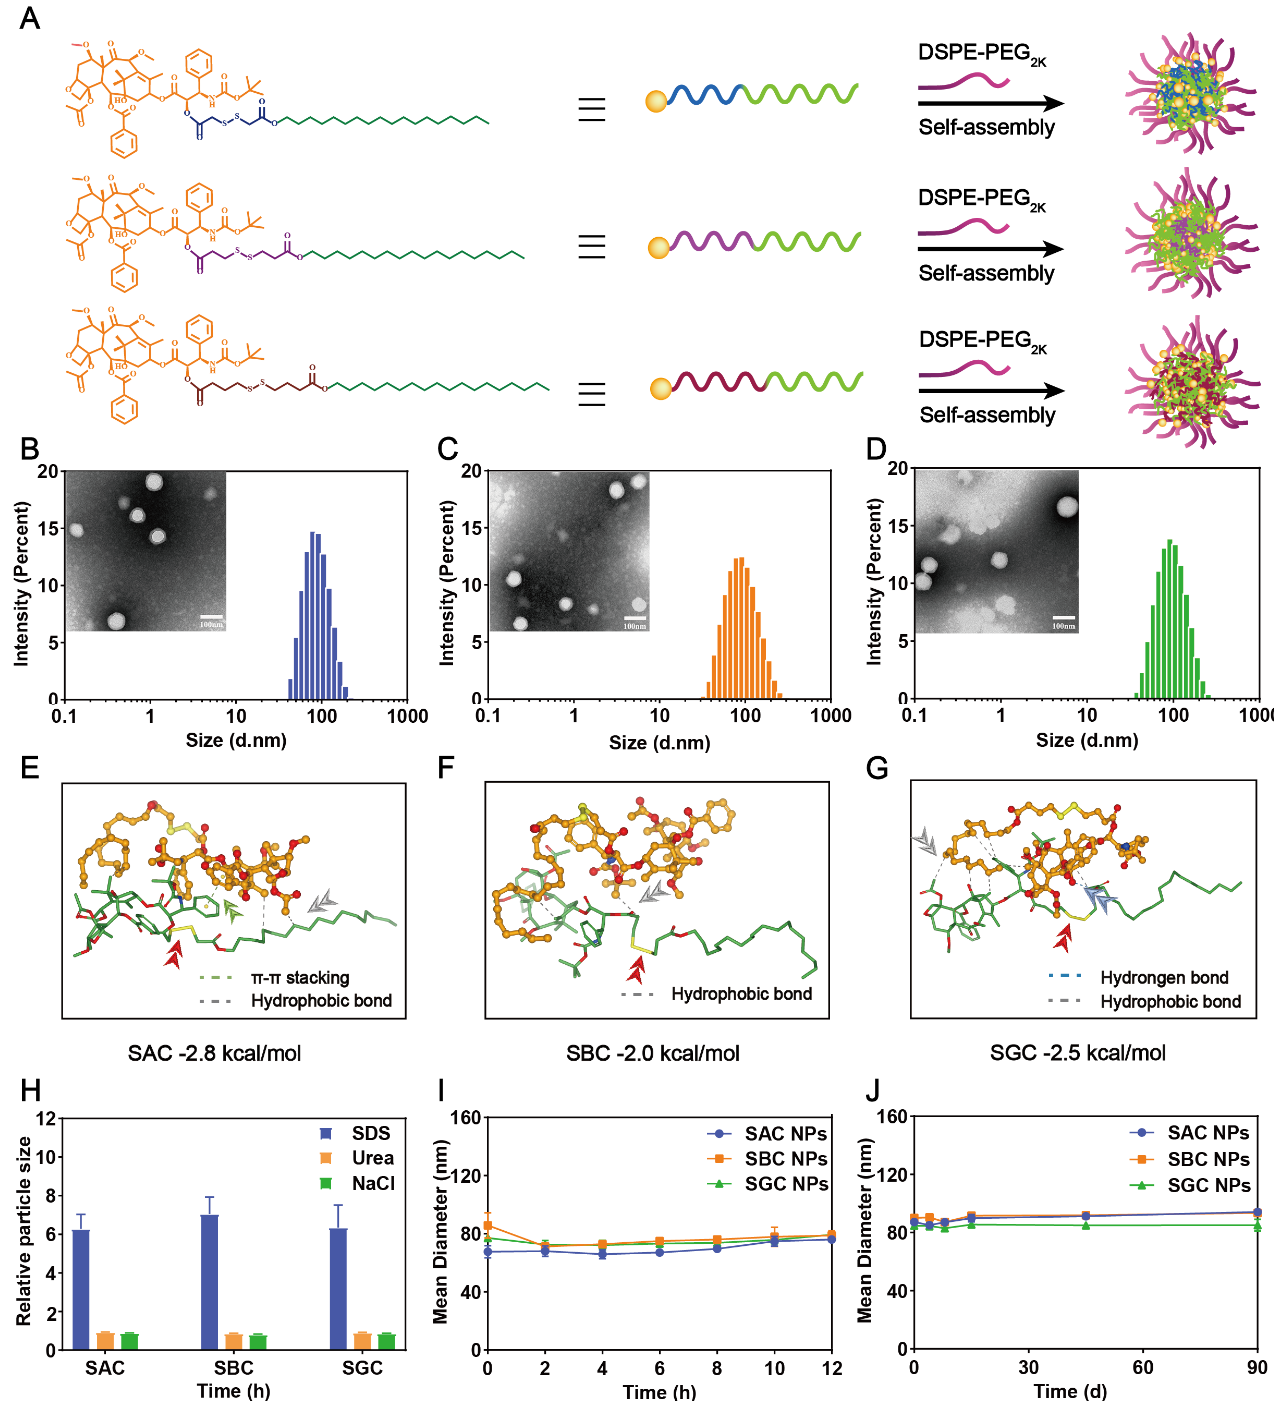
Figure 1. Preparation and characterization of CTX − prodrug nanoassemblies. ( A ) Schematic diagram of SAC NPs, SBC NPs and SGC NPs. Photographs and size distribution of SAC NPs, ( B ) SBC NPs ( C ) and SGC NPs ( D ). Scale bar represents 100 nm; Molecular docking simulation of SAC ( E ), SBC ( F ) and SGC ( G ); ( H ) The size change curves of NPs in the presence of NaCl, SDS and Urea; ( I ) Colloidal stability of NPs upon incubation with FBS − supplemented PBS (pH = 7.4, 37 ◦ C) at 37 ◦ C for 12 h ( n = 3); ( J ) Long-term colloidal stability of NPs at 4 ◦ C for 90